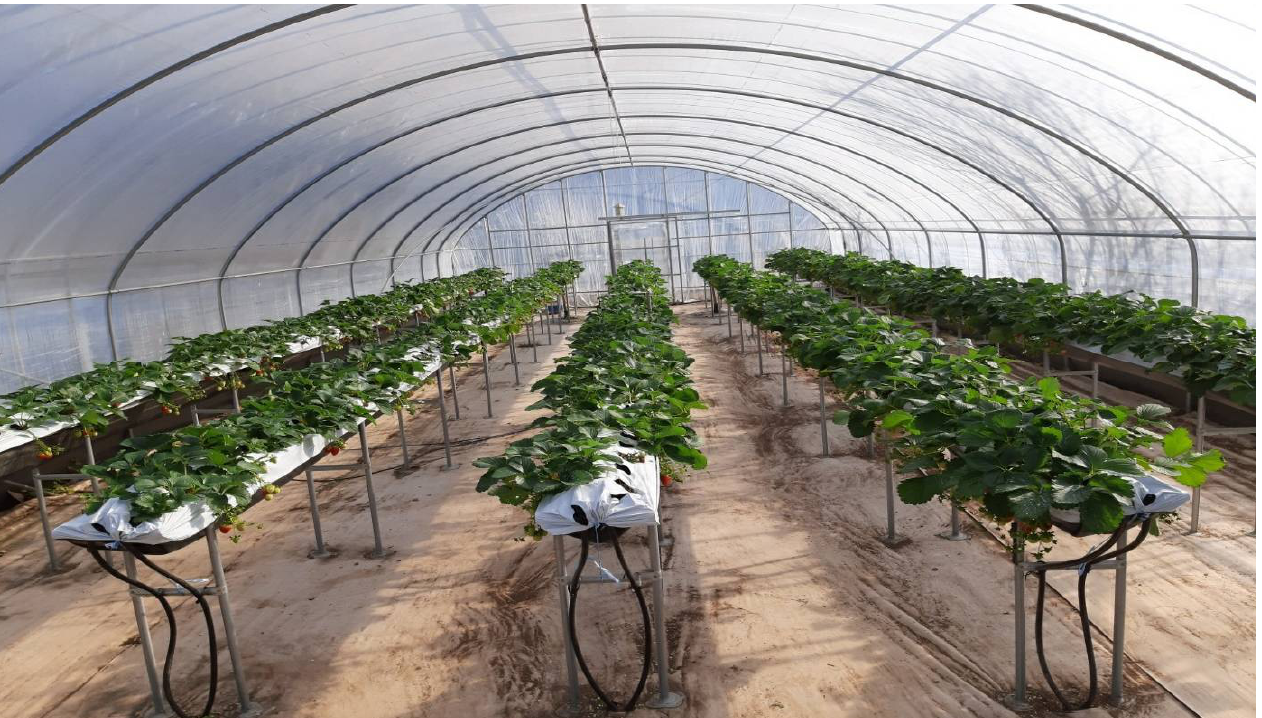
Figure 1. Experimental greenhouse for strawberry cultivation.